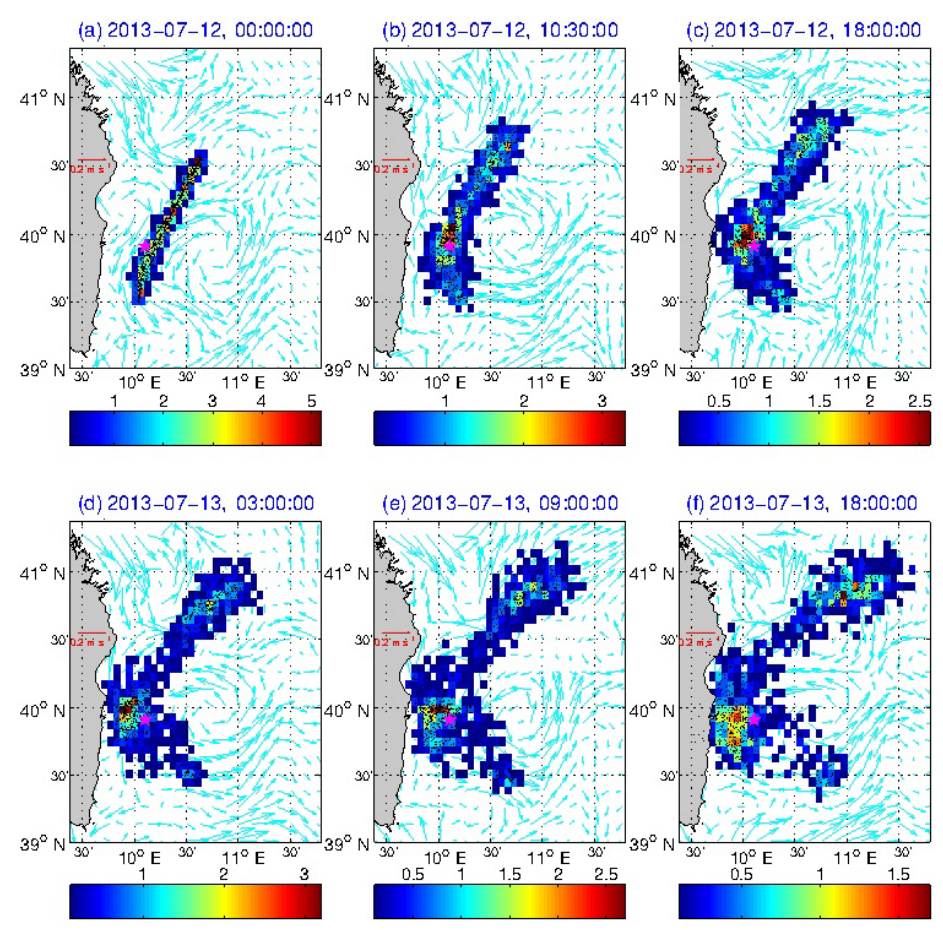
Figure 10. Here the slope standard error coefficient is 1 / 5, i.e., 4 times that proposed in Breivik and Allen (2008), while the offset error is 0.5 (unchanged compared to that proposed in Breivik and Allen (2008)). The yellow lines in Fig. 5 are the corresponding regression lines’ beams. Now the configuration seems good and the real event seems well